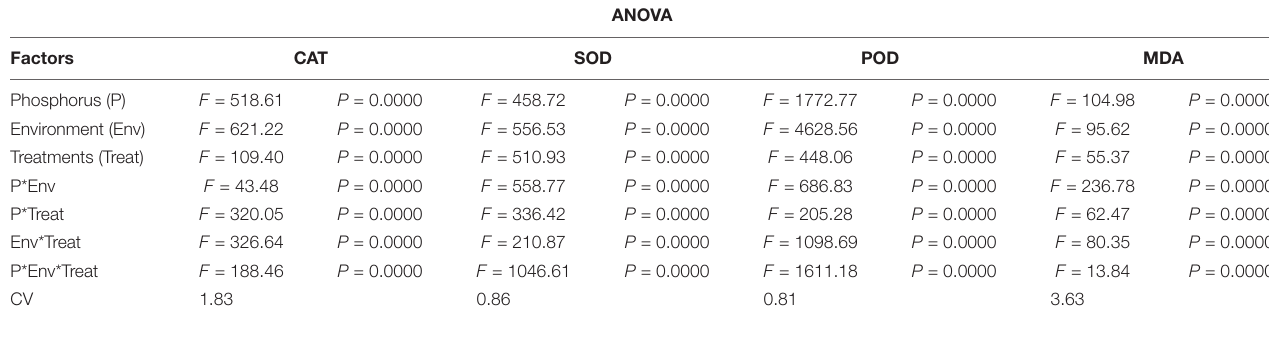
FIGURE 7 | Effect of Ti application on (A) Catalase (CAT), (B) Superoxide dismutase (SOD), (C) Peroxidase (POD), and (D) Malondialdehyde (MDA) activity of soybean leaf under NL and SC combined with LP and HP conditions. The bar plots with different lettering show the significant difference among cultivars at probability < 0.05. The error bars are the ± SD values with n = 3. TABLE 4 | Values under ANOVA are the F-test, probabilities ( P value) and coefficient of variation of the sources of variation (LSD, P <